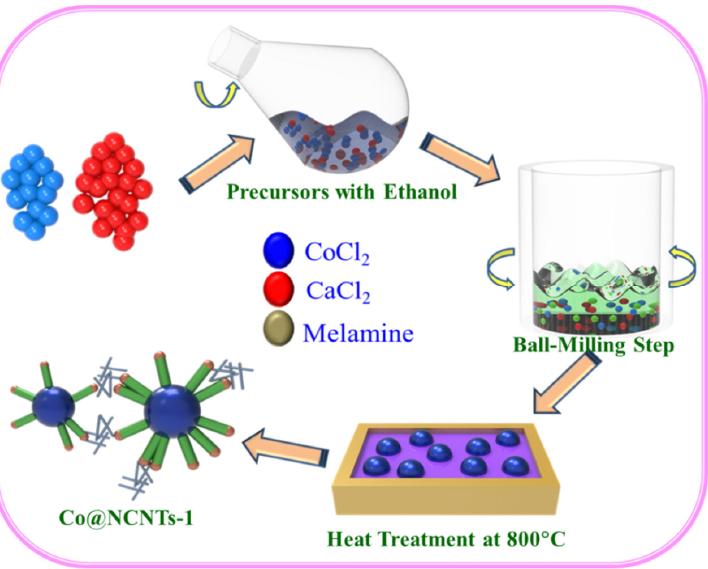
Figure 1. Representation showing the synthetic steps of Co@NCNTs 1 catalyst sample.